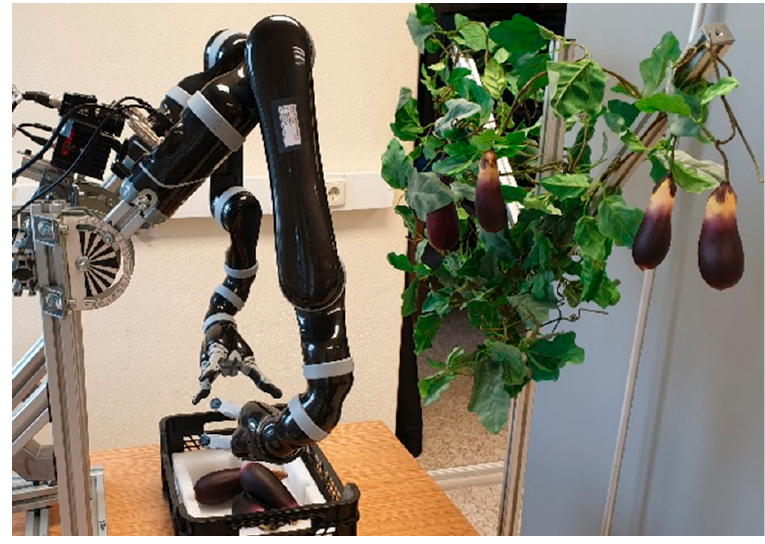
Figure 7. Dual-arm manipulator harvesting eggplants.